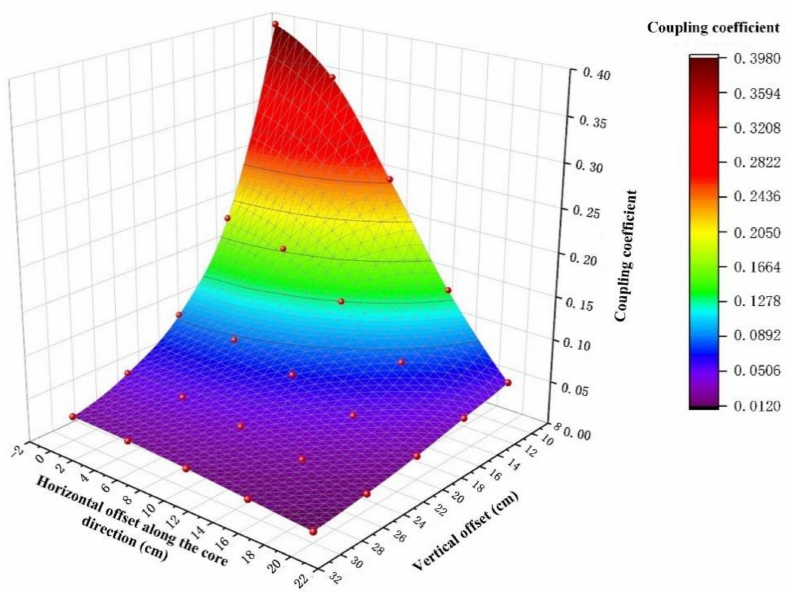
Figure 11. Relationship diagram of the coupling coefficient and misalignment perpendicular to the ferrite direction in a transformer with rectangular